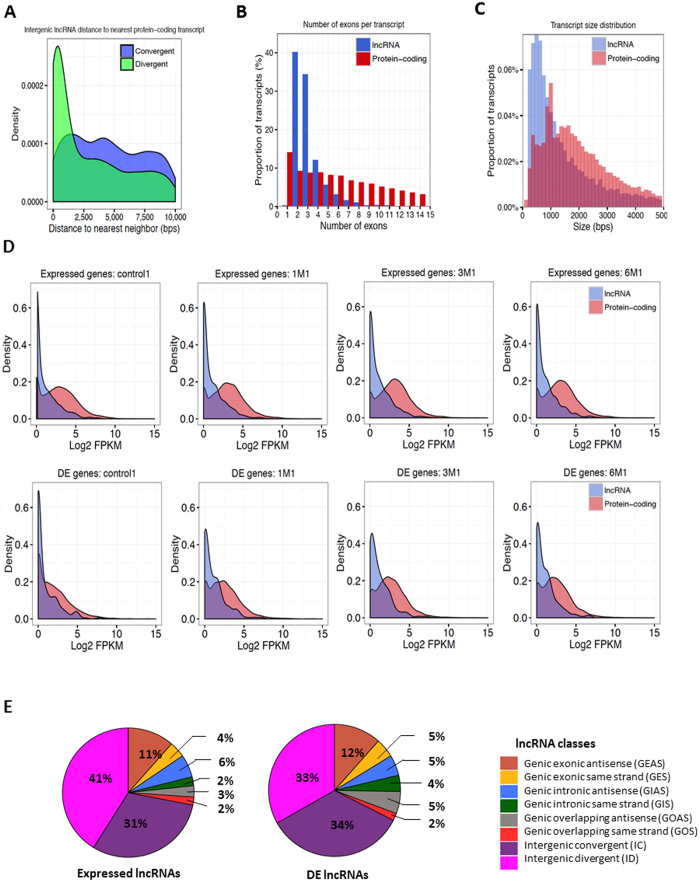
Characteristics of lncRNAs in the rat genome.(A) Distribution of the distances from IC lncRNAs (blue) or ID lncRNAs (green) to the closest protein-coding gene. Approximately 21.6% (1,039 out of 4,816) of ID transcripts and 10.4% (424 out of 4,059) of IC transcripts lie within 5 kb of a protein-coding gene (median distance 641 bp compared with 2,235 bp, respectively; t-test p < 1.41−29). (B) Number of exons per transcript for lncRNAs (blue) and protein-coding genes (red). The percentage of transcripts with only two exons is 40% and 7.5% for lncRNA and protein-coding transcripts, respectively. (C) Distribution of the transcript size of lncRNAs (blue) and protein-coding genes (red). The lncRNA transcripts are shorter than those of protein-coding genes (median transcript size 1,065 bp compared with 1,810 bp, respectively; t-test, p < 1.23−145). (D) Distribution of the FPKM values for DE lncRNAs (blue) and protein-coding genes (red) in control, 1 M, 3 M, and 6 M. Expressed and DE protein-coding genes displayed higher FPKM values in SCI samples when compared to control samples (1 M, 3 M, and 6 M compared with control for the expressed protein-coding genes: p < 8.17−19, p < 1.1−42, and p < 7.07−26; for DE protein-coding genes: p < 3.47−47, p < 1.34−92, and p < 3.14−62, respectively). (E) A pie chart depicting the distribution of each class of rat lncRNA (left: all expressed lncRNAs; right: DE lncRNAs post-SCI).